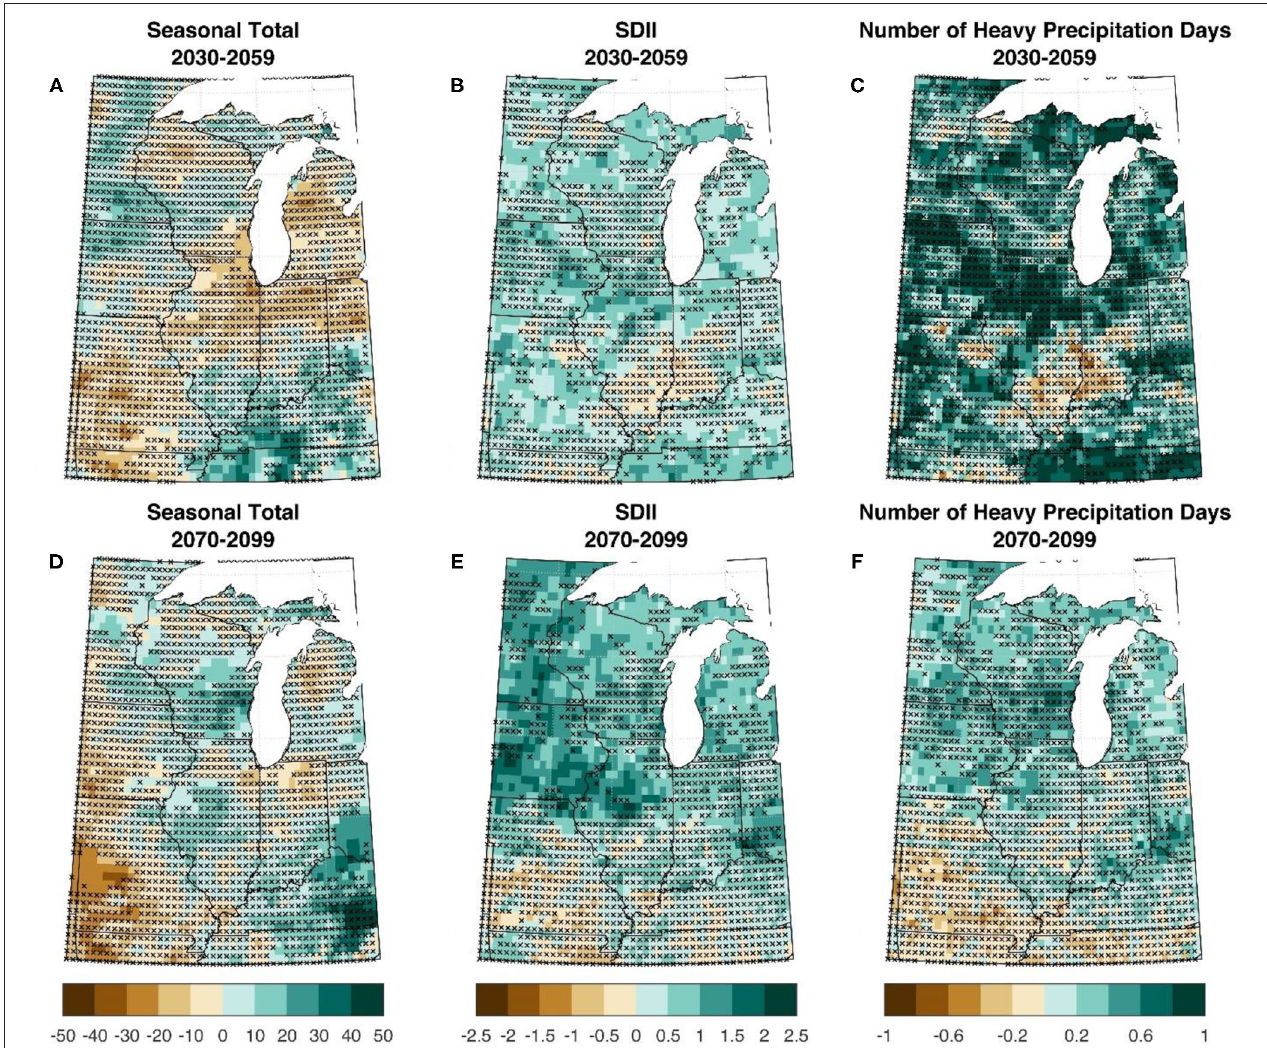
FIGURE 5 | The projected change in the 30-year summer climatology of the NA-CORDEX multi-model ensemble median in mid- (2030–2059) and late-century (2070–2099), relative to the model historical period (1976–2005). Shown are the seasonal precipitation totals [ (A,D) , mm], SDII [ (B,E) , mm day − 1 ], and the number of heavy precipitation days [ (C,F) , days]. Stippling represents areas where fewer than 9 of the 12 simulations agree on the sign of the